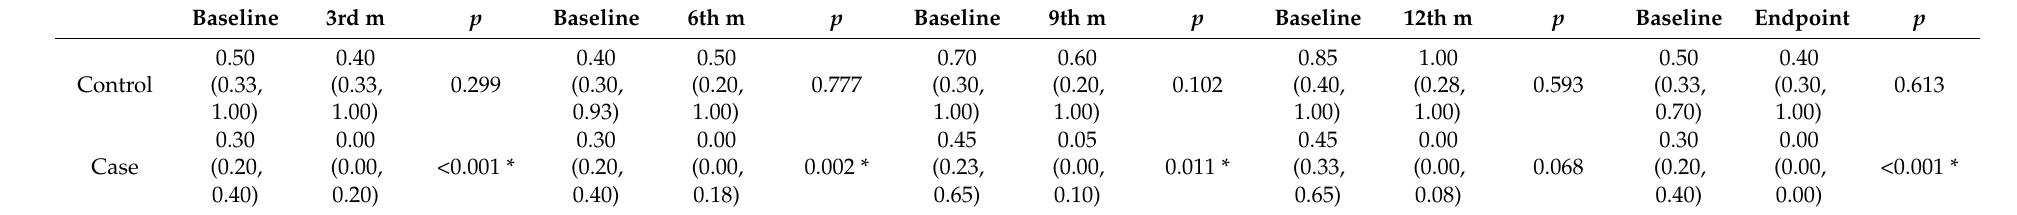
Table 3. Difference between follow-up and